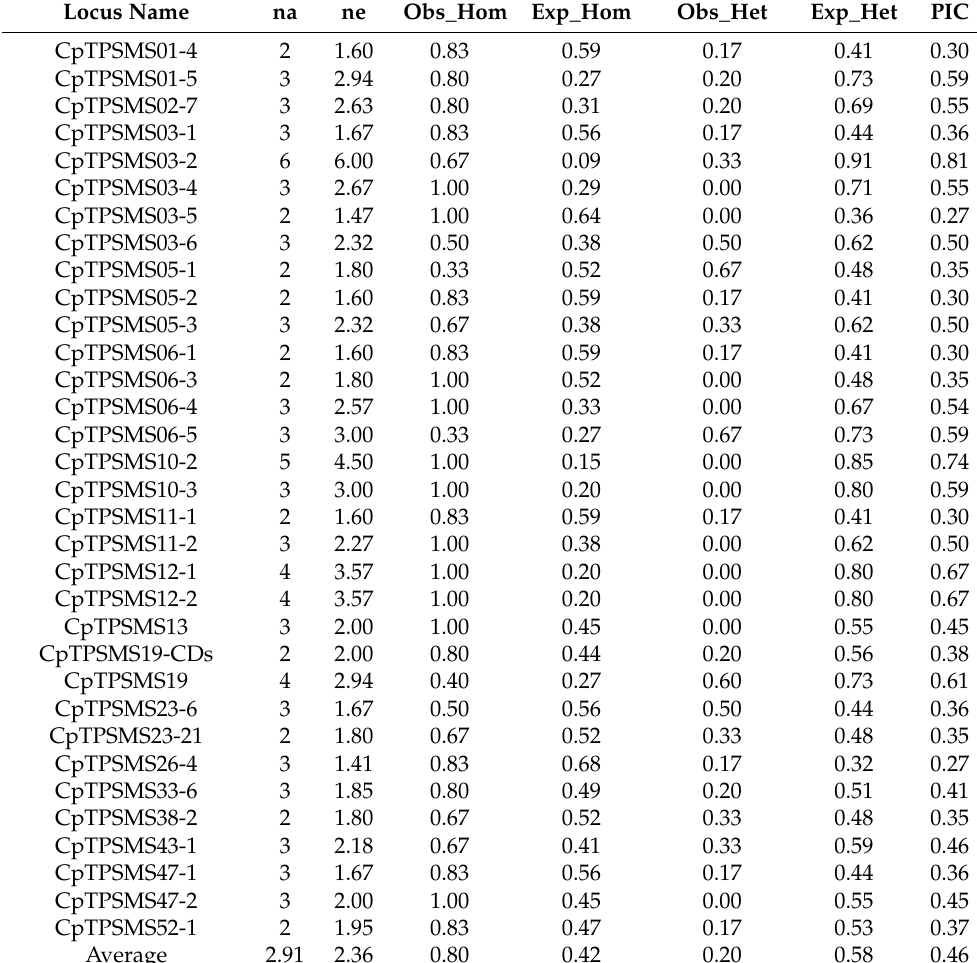
Table 4. Amplification characteristics of 33